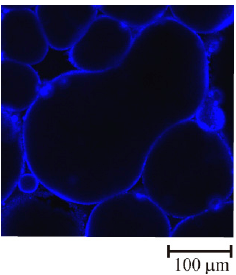
Figure 7. Confocal fluorescence image of the particles shells in an unstable, compressed Pickering emulsion showing a coalesced droplet fused into a doublet shape. Adapted from [111] with permission from the Royal Society of Chemistry.